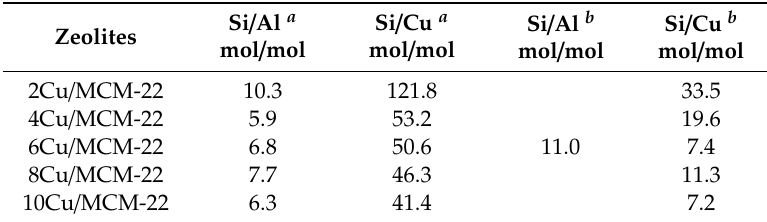
Table 4. XPS and ICP-AES results of x Cu / MCM-22 zeolites.